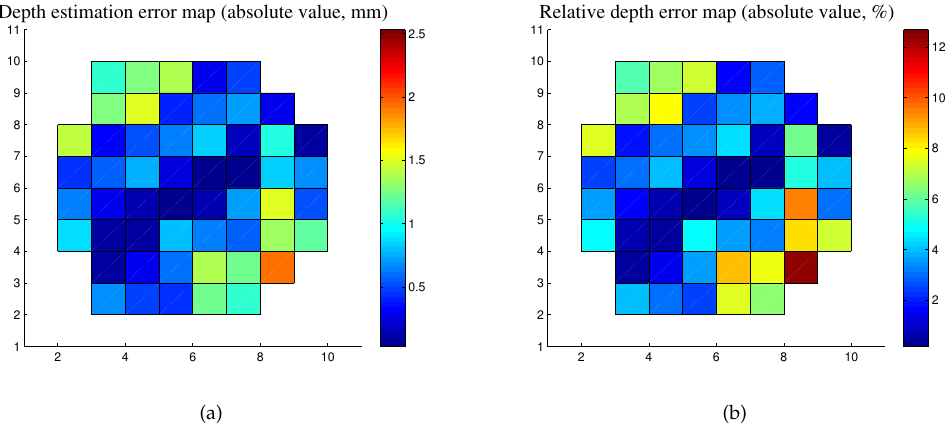
Figure 9. Depth estimation error distribution of the specular highlight region. ( a ) Depth estimation error map (absolute value). ( b ) Relative depth error map (absolute